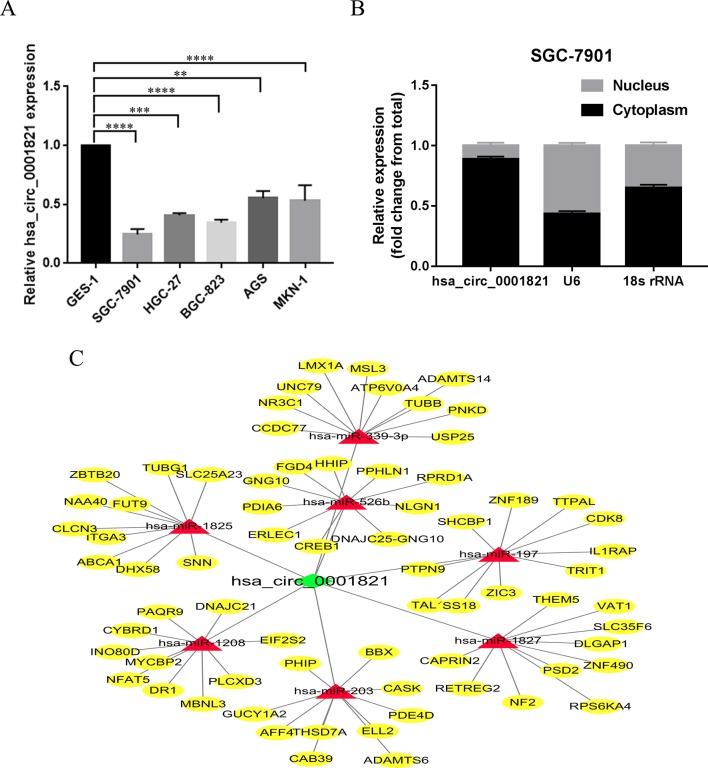
Exploration of the downstream regulatory network of hsa_circ_0001821 in gastric cancer (GC) cells. (A) Detection of hsa_circ_0001821 expression in five GC cell lines. (B) Detection of hsa_circ_0001821 location in SGC-7901 cell line by nucleoplasm separation assay. (C) Prediction of circular RNA (circRNA)-microRNA (miRNA)–messenger RNA (mRNA) network map of hsa_circ_0001821. The green diamond represents hsa_circ_0001821, and the red rectangle represents seven miRNAs that could interact with hsa_circ_0001821, while the yellow oval represents the target mRNA of the corresponding miRNA.